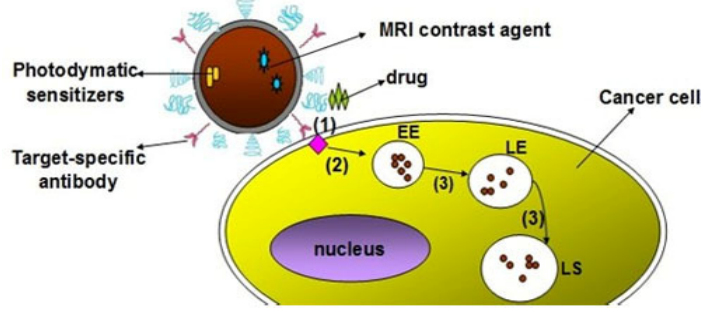
Figure 2. Schematic representation of delivering QDs into cells, the process comprises of three major stages: ( 1 ) endocytosis; ( 2 ) sequestering in early endosome (EE); ( 3 ) translocation to later endosomes (LE) or lysosomes